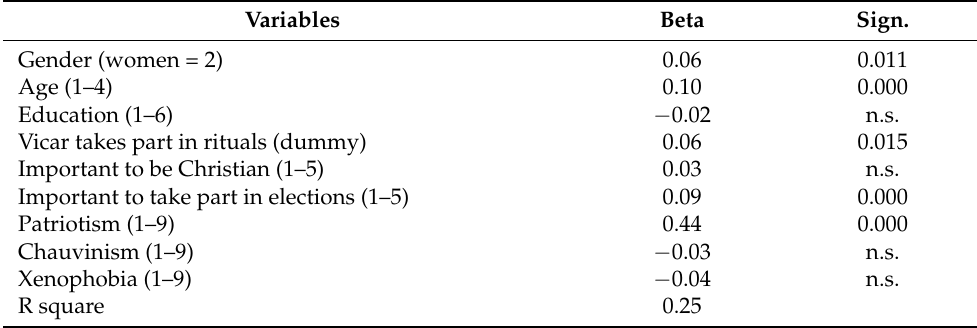
Table 6. Regression analysis where thinking it is important to celebrate National Day is the dependent variable (Beta and r square). N =